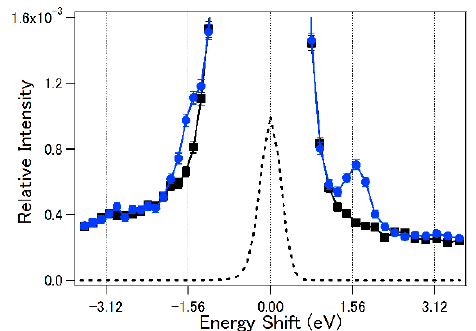
Figure 3. The energy spectra of the relative intensities of scattered electron signals [9]. The intensity was normalized with respect to the peak intensity of the n = 0 scattering signal. Estimated statistical error bars are derived from the square roots of the signal counts. Blue filled circles are the electron signals recorded with vertically polarized laser fields; black filled squares are the background signals; and the black broken line is the n = 0 scattering peak reduced by a factor of 1000. The experimental conditions were the same as those in Figure 2.